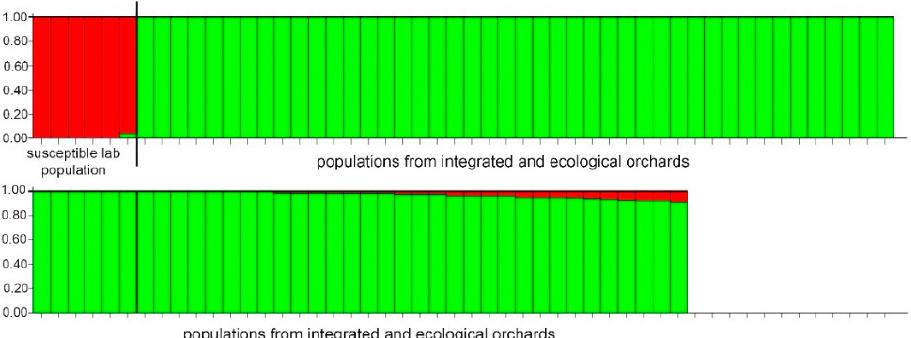
Figure 5. STRUCTURE analysis of 94 CM genotypes using SNP markers.